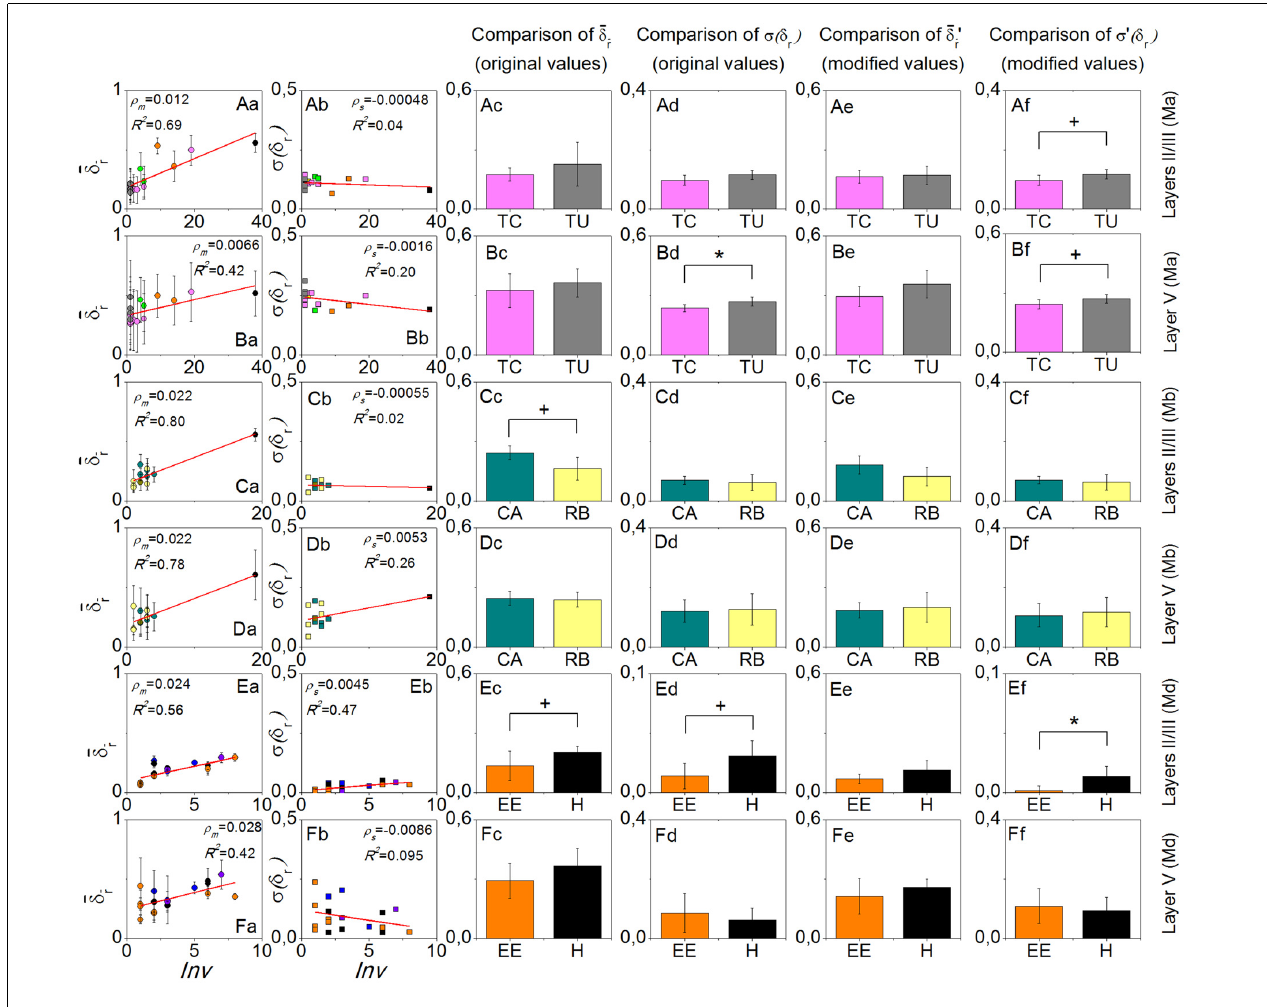
FIGURE 3 | Results of the environment-repeat prediction. Rows from top to bottom are layers II/III of mouse Ma, layer V of mouse Ma, layers II/III of mouse Mb, layer V of mouse Mb, layers II/III of mouse Md, and layer V of mouse Md. The first column is the dependence of ¯ δ r on the environment-repeat interval Inv, where error bars in fact indicate the standard deviation σ ( δ r ) , and the red lines are the linear fitting results. The second column shows the dependence of σ ( δ r ) on Inv. The third to the sixth columns show the comparisons of ¯ δ r and σ ( δ r ) with the original and modified data, respectively, between the most often repeated environments that each mouse experienced. Colors in the figure are used to discriminate environment types. + p < 0.1 and * p <